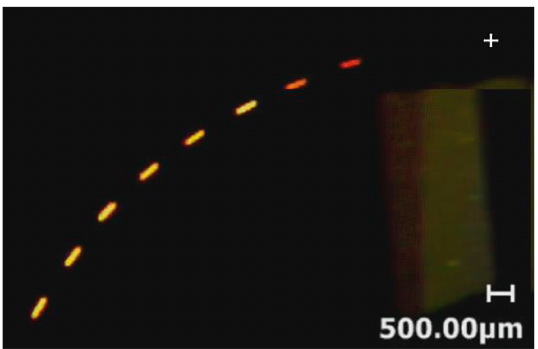
Figure 5: The spark flight path at a critical speed.